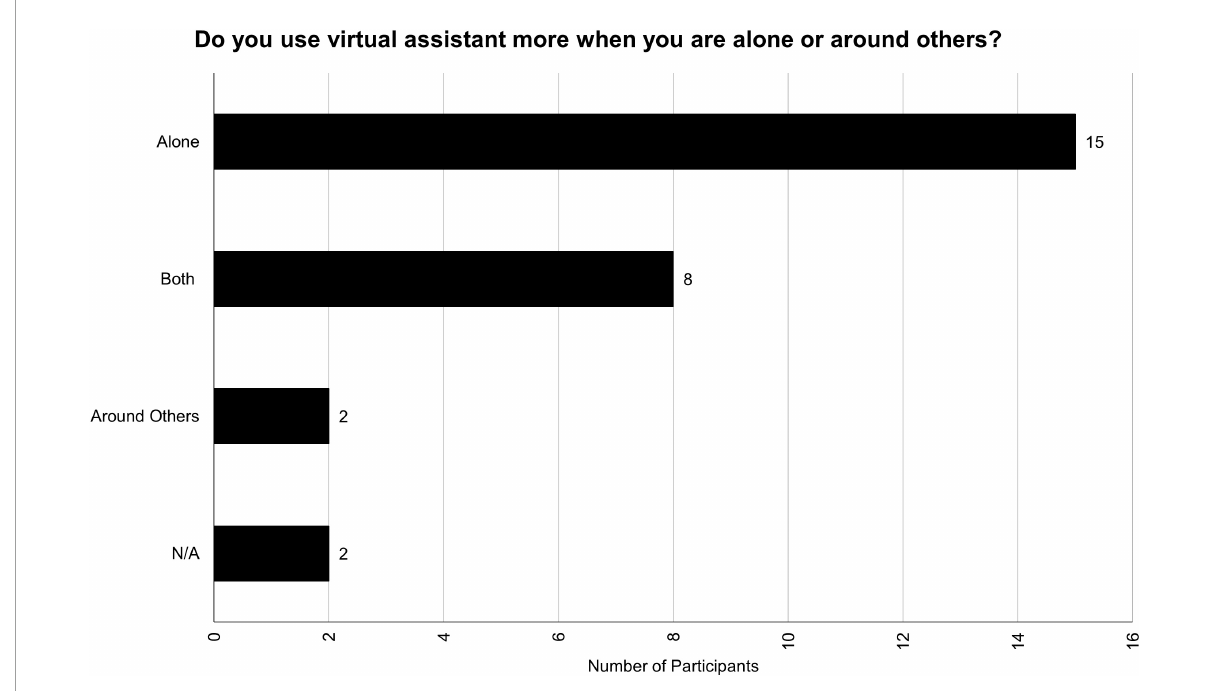
FIGURE3 Do you use a virtual assistant more when you are alone (not around other people) or when you are around other people (with friends, on the train, shopping)?